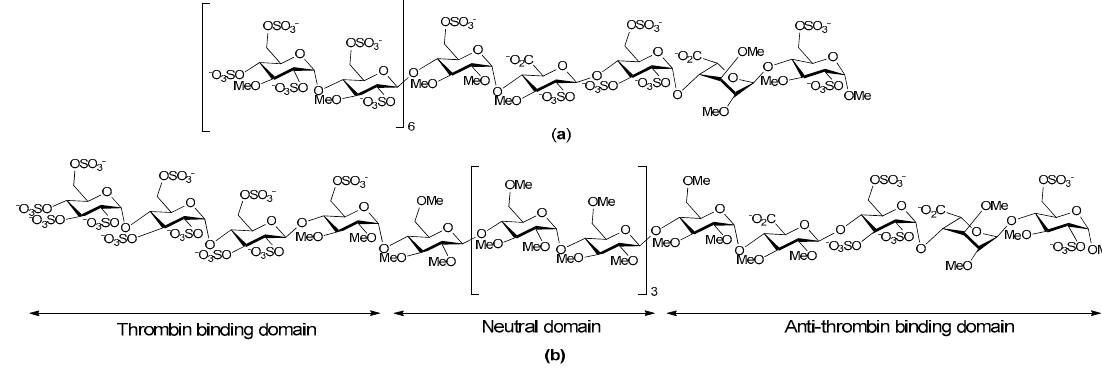
Figure 3. Chemical structure of ( a ) 17-mer saccharide; ( b ) SR123781.